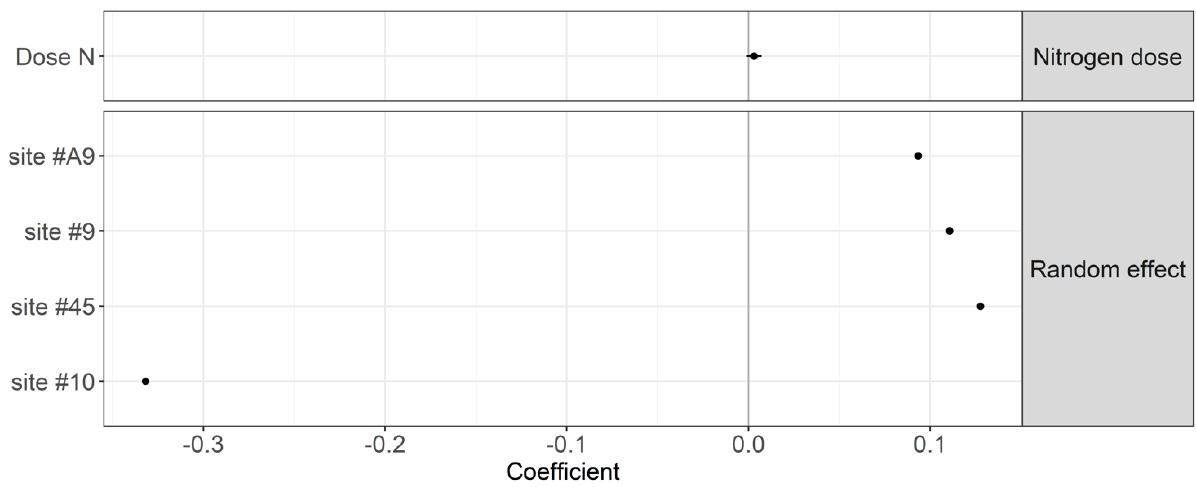
Figure 3. Coefficients of the mixed model linking the TBI decomposition rate (k) to the N dosage and sites with a 95% compatibility interval.